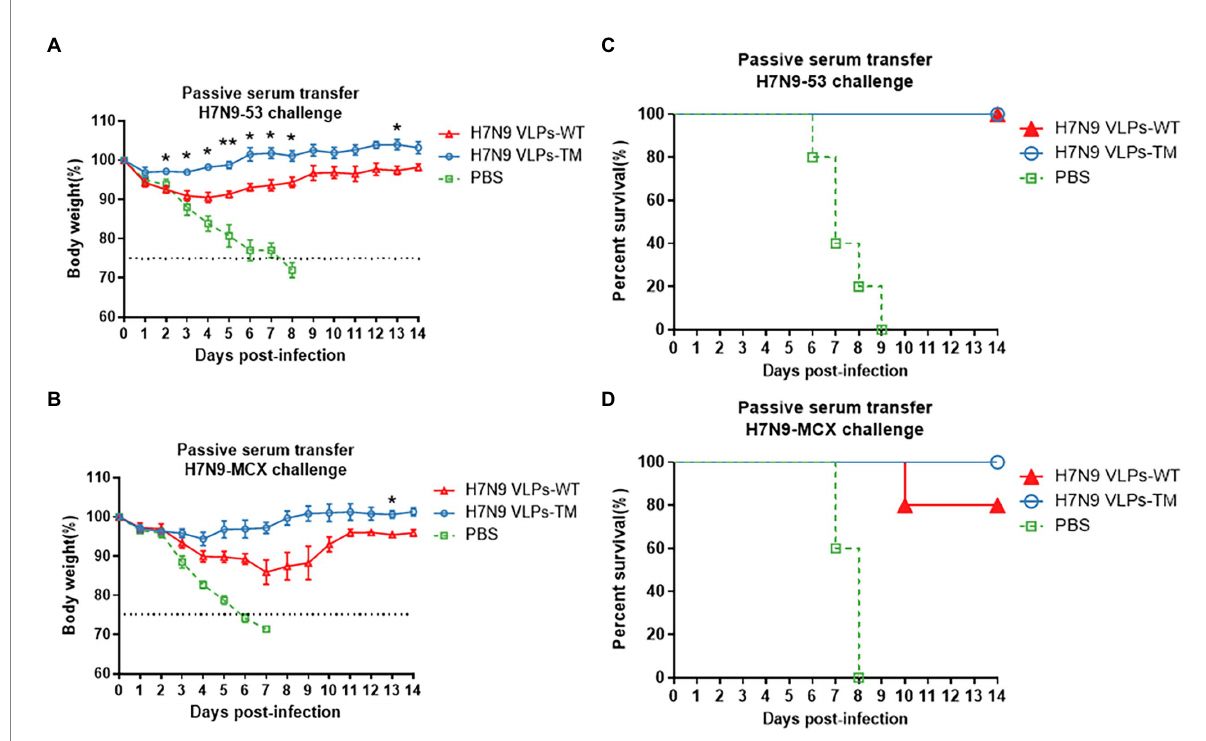
FIGURE 2 Protection of mice passively immunized with sera and then challenged with homologous and heterologous viruses. (A) Weight loss of challenged with H7N9-53. (B) Weight loss of challenged with H7N9-MCX. (C) Survival rate of challenged with H7N9-53. (D) Survival rate of challenged with H7N9-MCX. Statistical difference between two groups was indicated by * p < 0.05, ** p < 0.01, *** p <